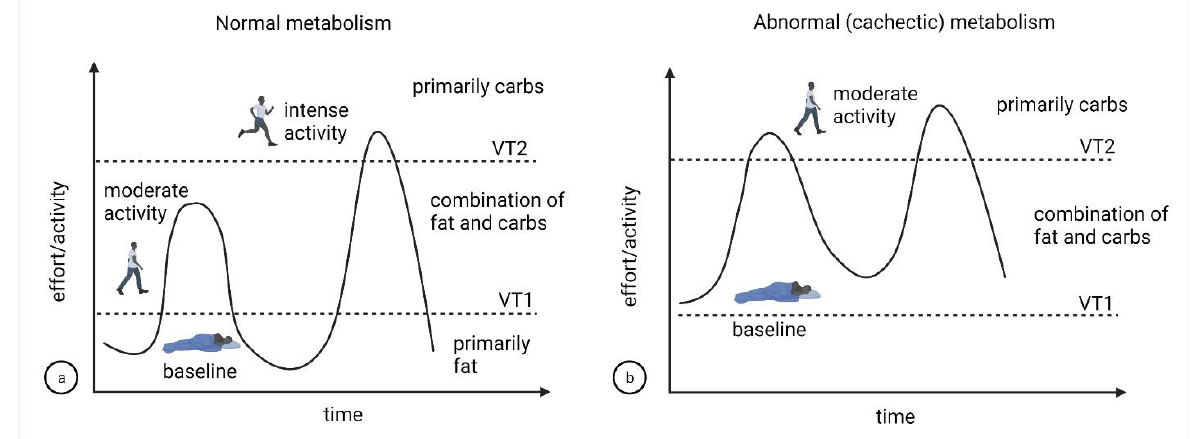
Figure 4. Schematic of proposed differences in metabolism-effort relationships for individuals with ( a ) normal metabolism vs ( b ) cachexia.